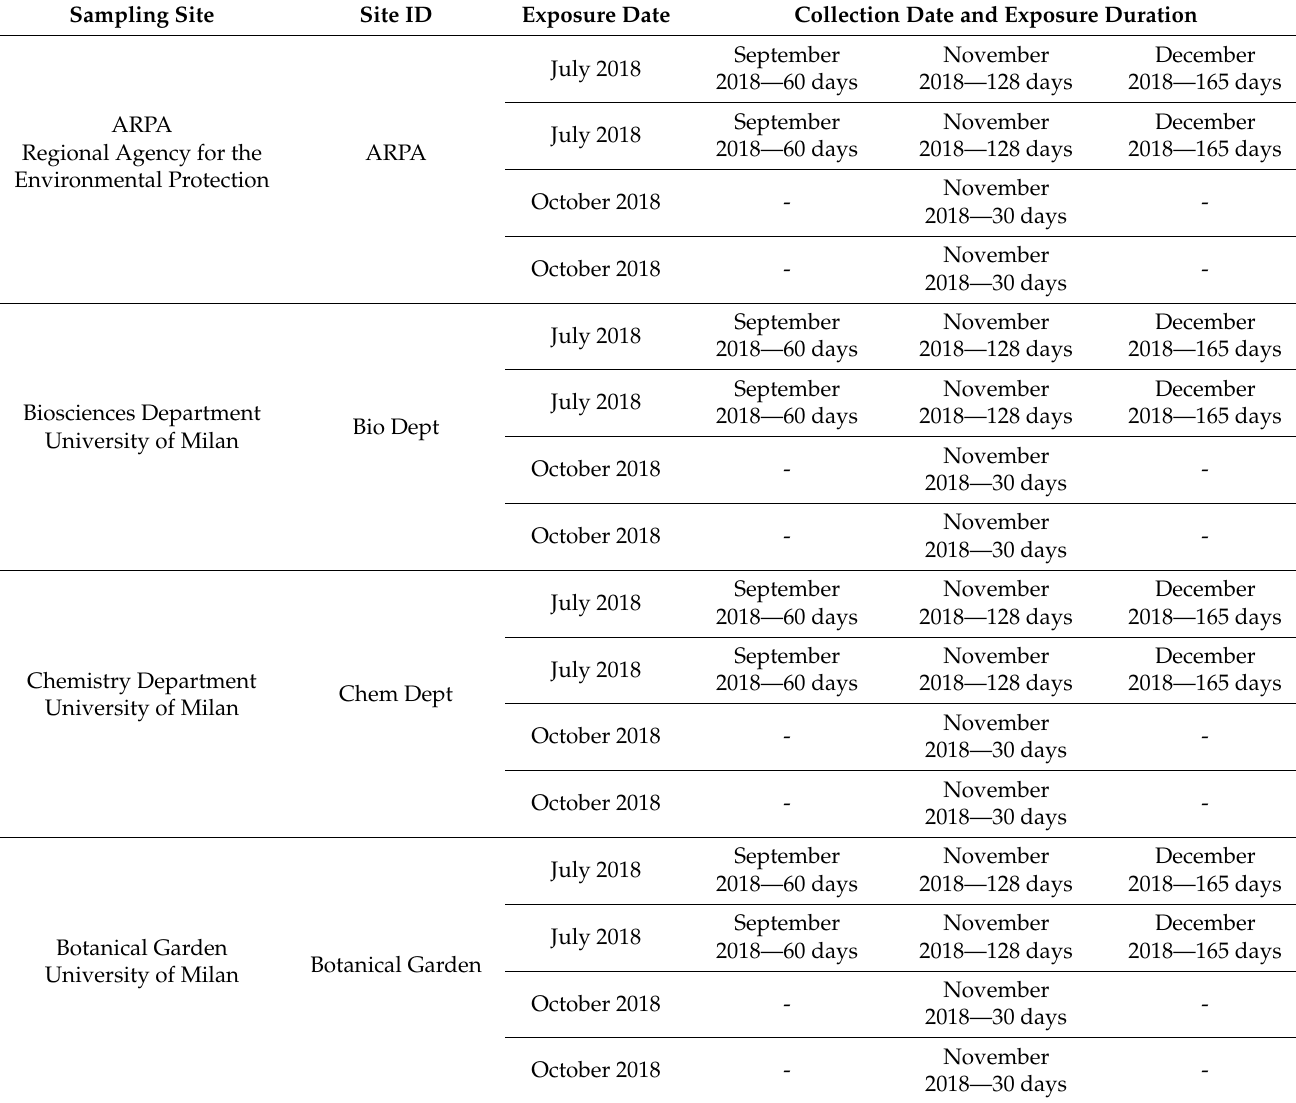
Table 1. Sampling sites where Chlorophytum comosum plants were exposed in Milan together with exposure date, collection date and exposure duration; 4 plants were exposed in each site, 2 in July and 2 in October; for the plants exposed in July a collection at 7 days, not indicated in the table, was also performed; samples collected at 30 days come from plants exposed in